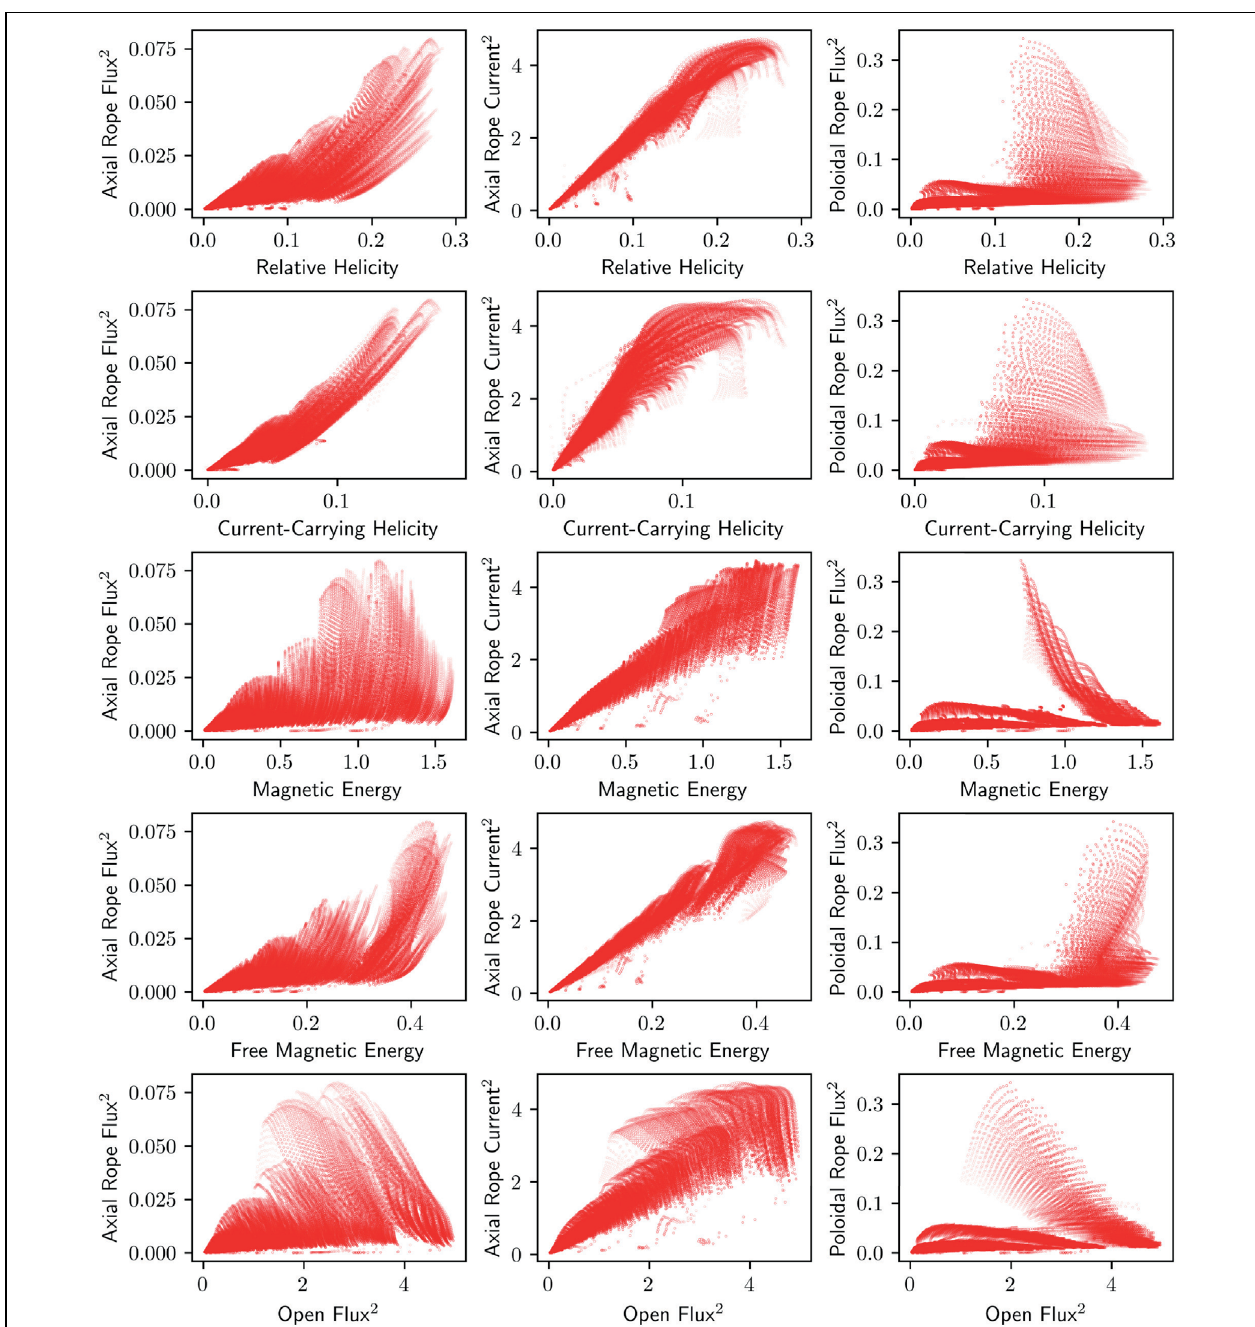
FIGURE 8 | Pairwise scatter plots of the diagnostic values for all snapshots with later flux rope eruptions, in order to establish whether the ratios of the diagnostics are good predictors. The sizes of the points are weighted based on proximity to the eruption, such that the larger points are close to eruptions and vice versa.